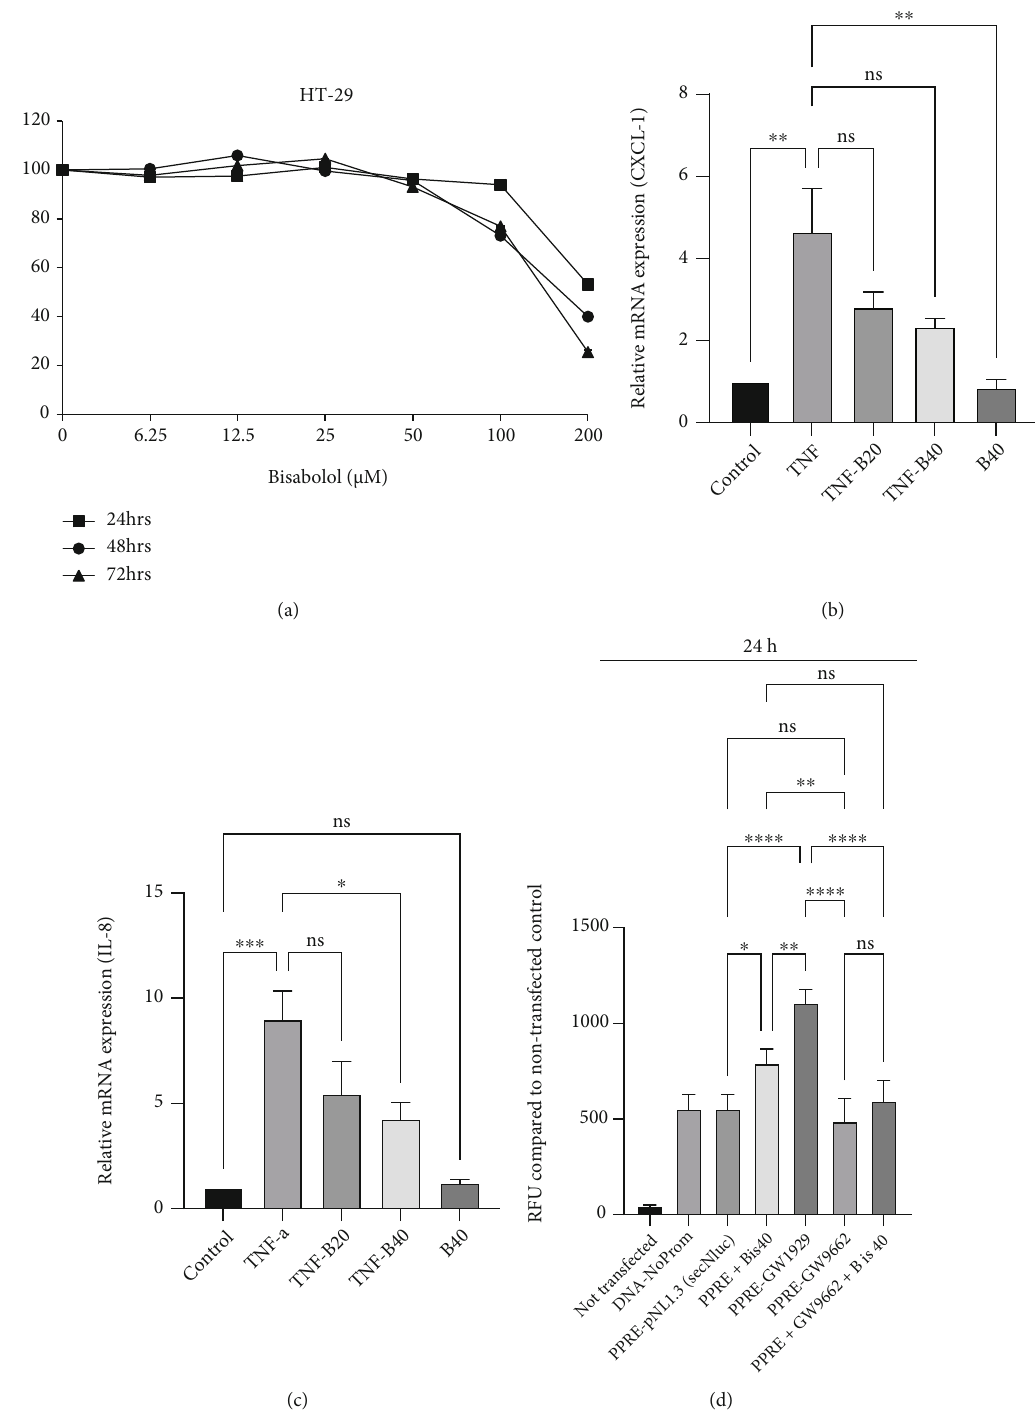
Figure 7: E ff ect of bisabolol on TNF- α challenged HT-29 colonic adenocarcinoma cell proin fl ammatory cytokine mRNA expression and PPAR-gamma promoter assay. Lower concentrations of α -bisabolol had no a ff ect on HT-29 cell viability, but higher concentrations and longer time had a negative impact on cell viability (a). α -Bisabolol signi fi cantly decreased the expression of proin fl ammatory cytokine mRNA [CXCL-1 (b) and IL-8 (c)] in TNF- α challenged HT-29 cells. The full-length sequence of PPAR- γ was cloned into PPRE-pNL1.3 [secNluc] plasmid transfected using lipofectamine LTX in HT-29 cells. α -Bisabolol(40 μ M), GW1929 [PPAR γ agonist (1 μ M)], or GW9662 [PPAR γ antagonist (1 μ M)] compared to PPRE-pNL1.3 [secNluc] transfected plasmid controls. Luciferase expression at 24 h was determined in 50 μ L supernatant culture media using a luminometer. Four ( n = 4 ) separate experiments carried out to obtain data points. The data expressed mean ± SEM . ∗ p < 0 : 05 , ∗∗ p < 0 : 01 , ∗∗∗ p < 0 : 001 , and ∗∗∗∗ p < 0 : 0001 . ns: not signi fi